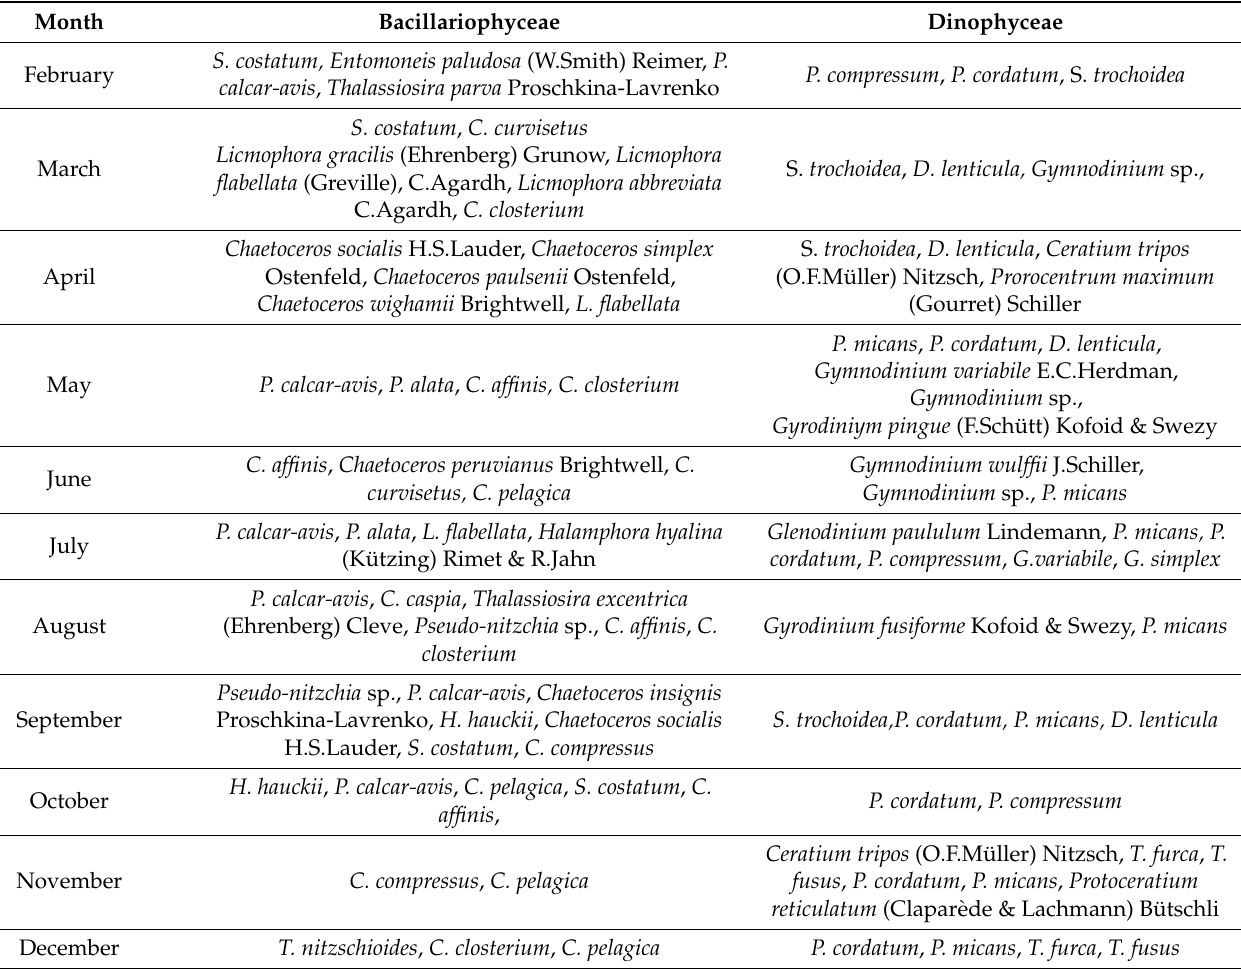
Table 2. Dominant species in the phytoplankton of station 1 and station 2 in